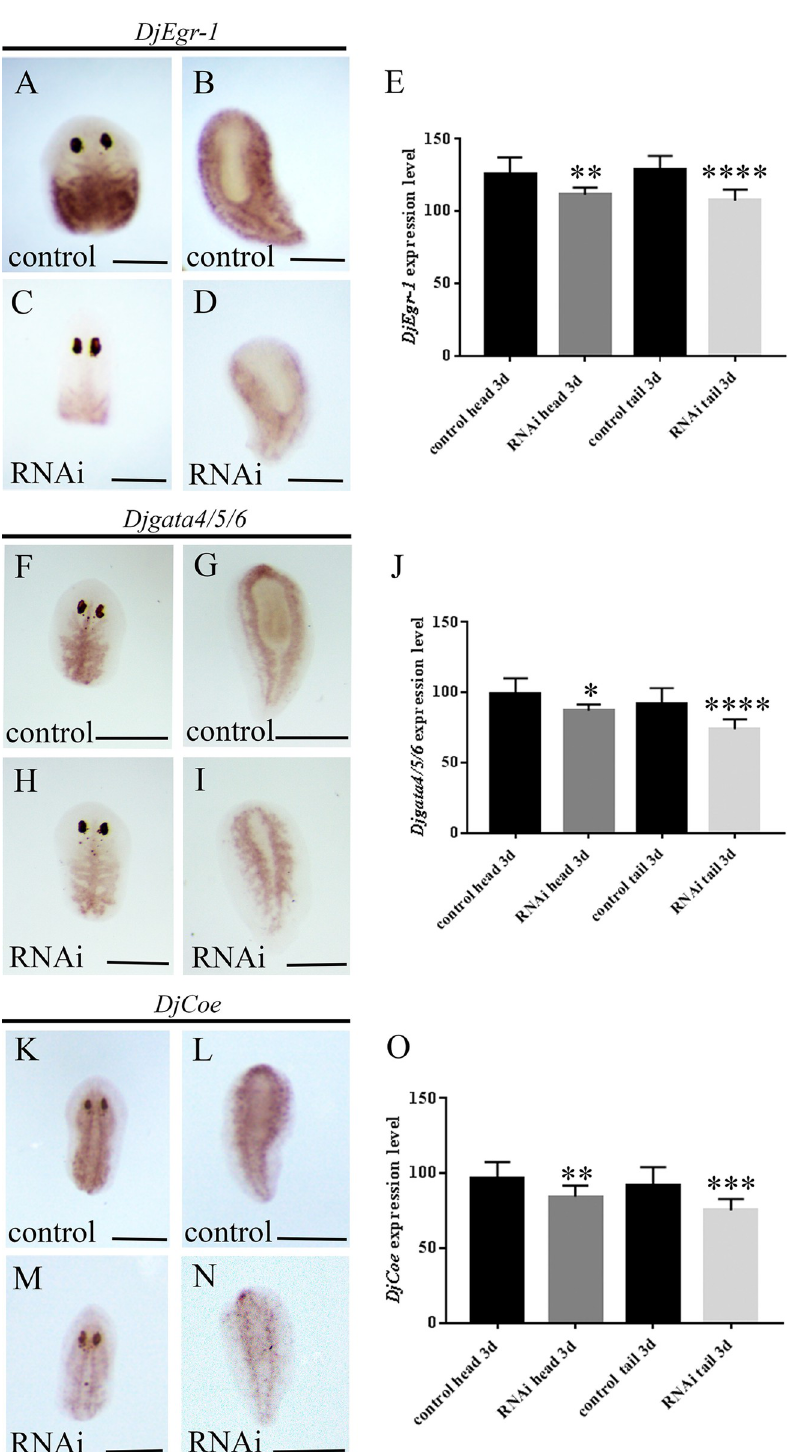
Fig 4. Analysis of marker expression for committed neoblasts in DjMap1B silenced animals by WISH 3 days after amputation. (A) Representative images of DjEgr-1 expression in a regenerating control head and (B) tail fragment. (C) Representative images of DjEgr-1 expression in a regenerating DjMap1B -silenced animals (RNAi) head and (D) tail fragment. (A-D) are dorsal view. (E) Graph depicting the quantification of DjEgr-1 expression level. (F) Representative images of Djgata4/5/6 expression in a regenerating control head and (G) tail fragment. (H) Representative images of